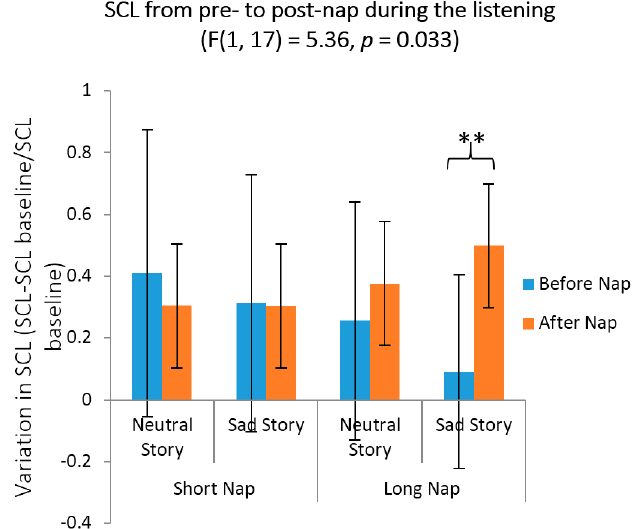
Figure 4. Skin conductance levels (SCL) during the first and second story listening by group (long and short naps) and story type (neutral and sad). Each bar represents the change from baseline SCL averaged over the 10-min audition of the story. Pre- to post-nap listening difference are indicated by asterisks when significant, * p <0.05, ** p < 0.01.